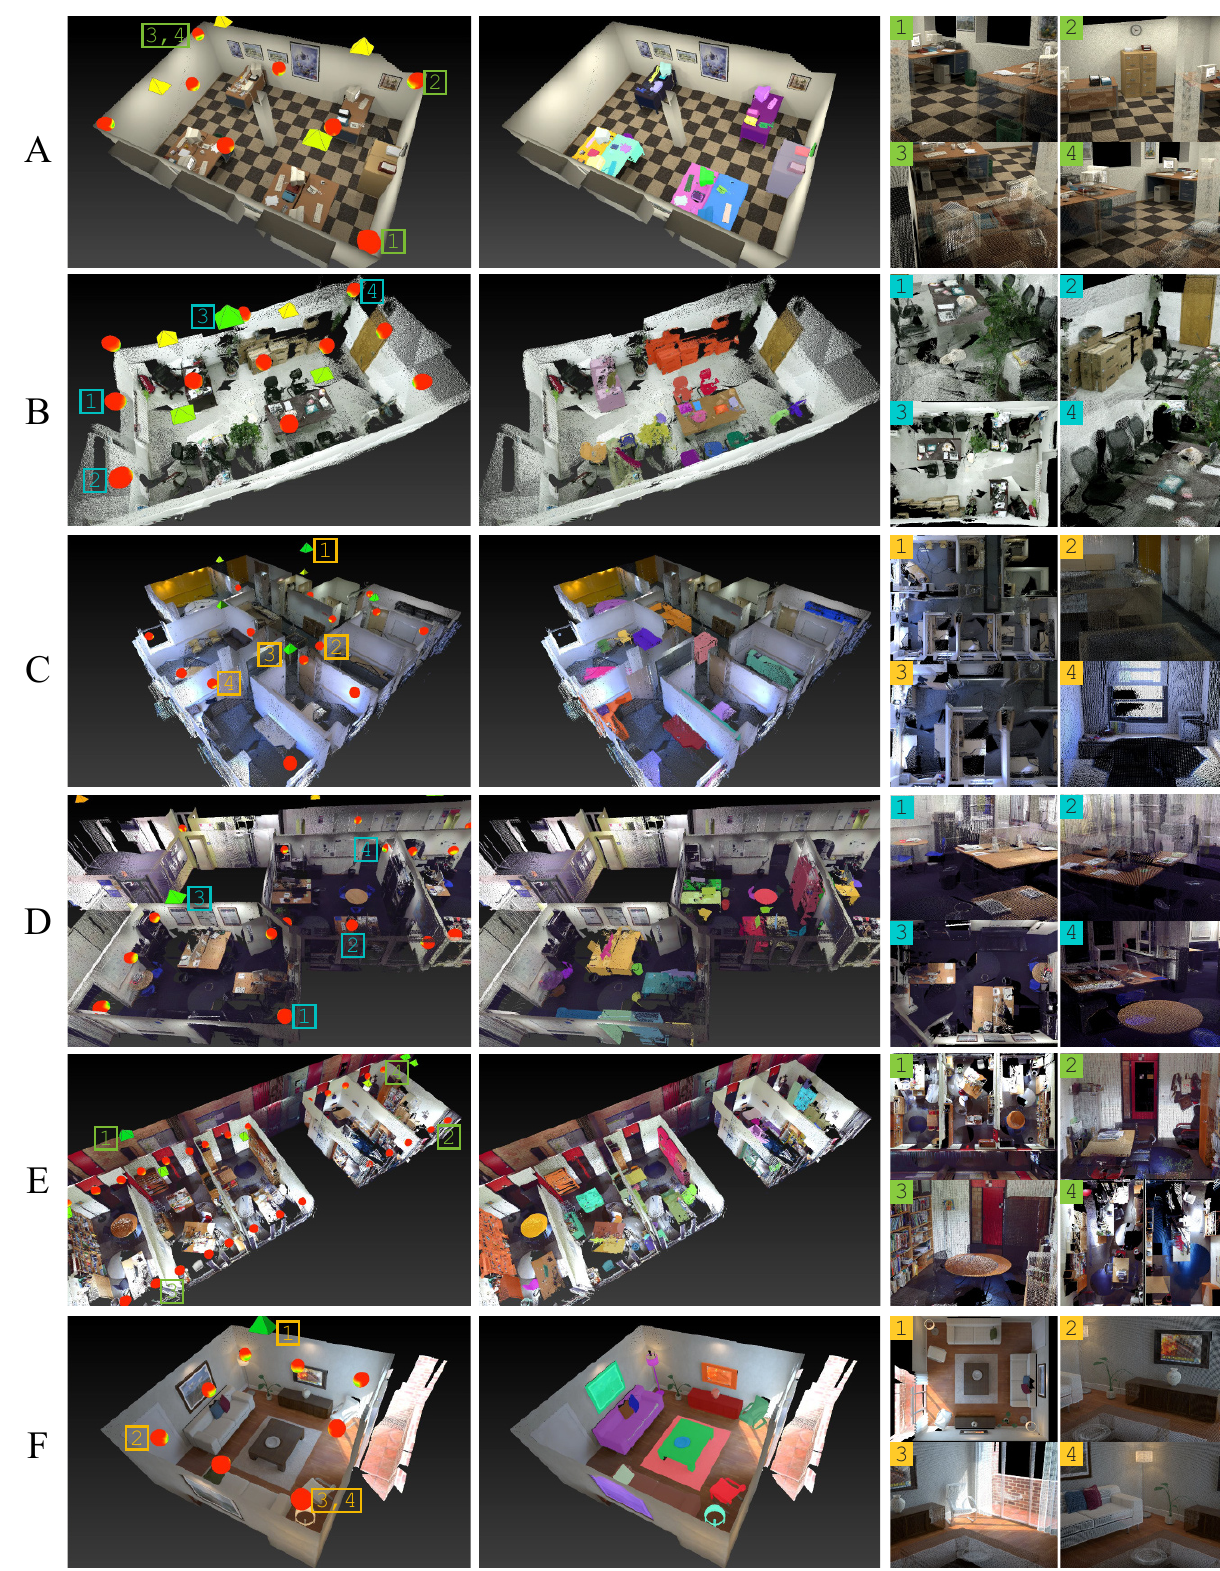
Fig. 9 Examples of results of our system. Left: view score map. Right: high score examples when no objects are